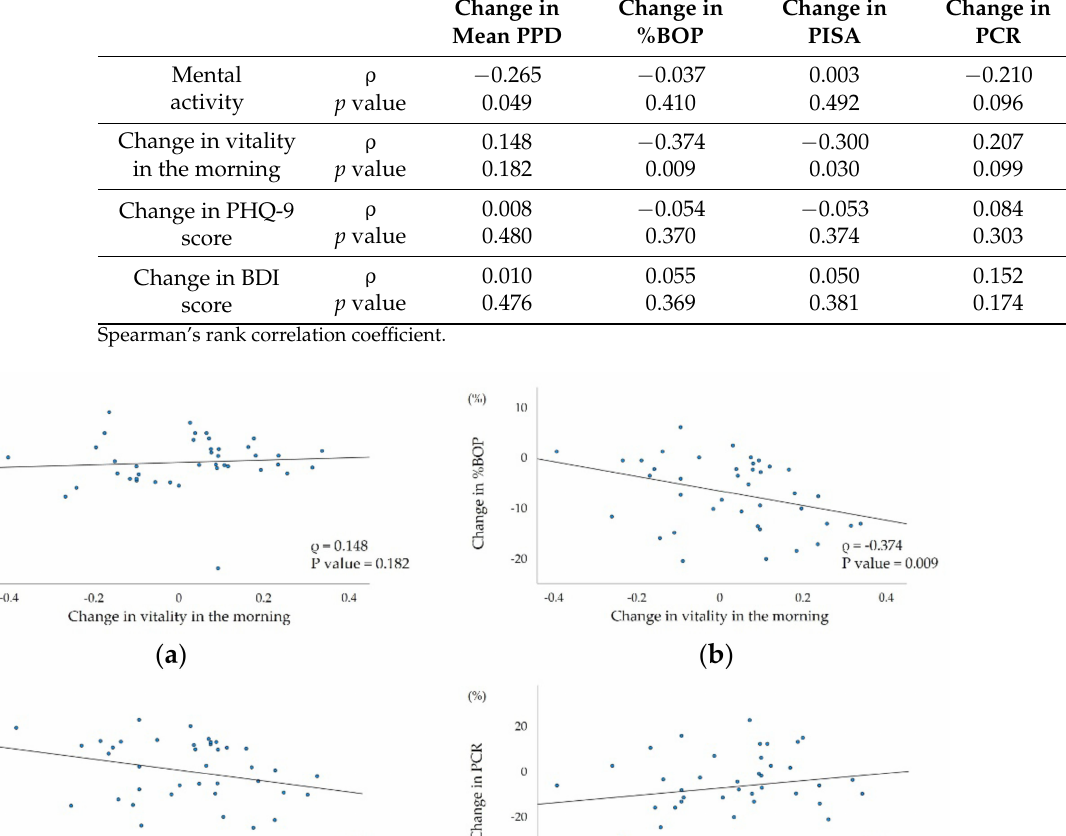
Table 3. Correlation between mental activity, changes in vitality in the morning, PHQ-9, and BDI score and oral health status. Change in Mean PPD